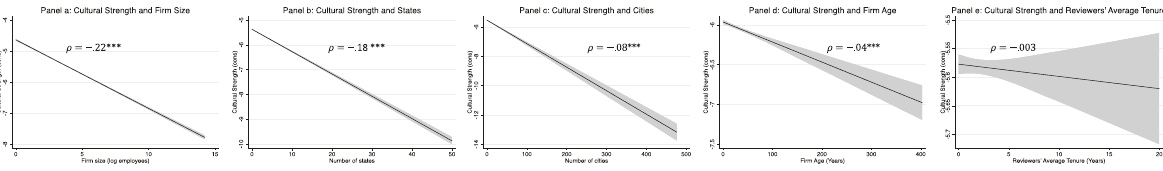
Fig. 6 Theory-driven covariates of cultural strength (computed on “ cons ” ). In Fig. 6, we report results from bivariate analysis showing the correlation of cultural strength with theoretically relevant variables of interest. + p < 0.1; * p < 0.05; ** p < 0.01; *** p < 0.001.